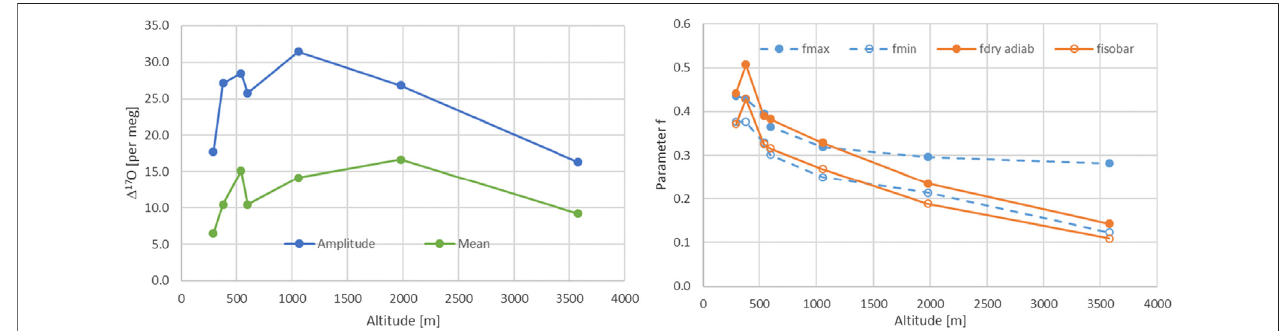
FIGURE6| Leftpanel,meanandamplitudeof Δ 17 OforallofthesevenSwissstations.Rightpanel,comparisonofthefvaluesoftheRayleighmodel,corresponding to the remaining water content, calculated based on the stations metadata from MeteoSwiss (orange) for the isobaric and dry adiabatic case and the corresponding values based on maximal and minimal y-values (see text).